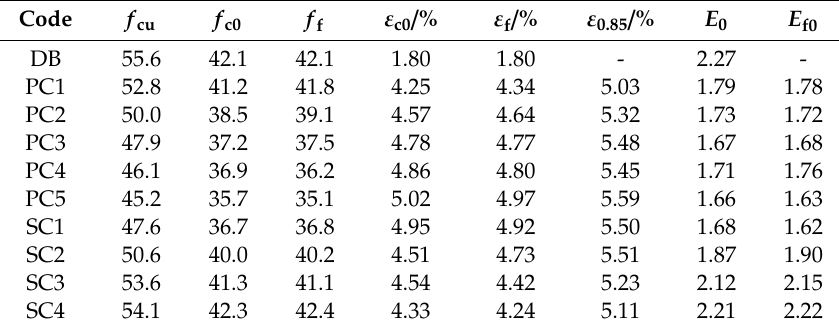
Table 3. Mean value of characteristic point on σ - ε curve.